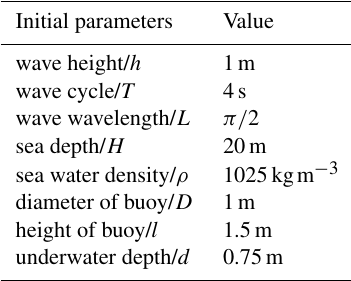
Table 2. Initial conditions.